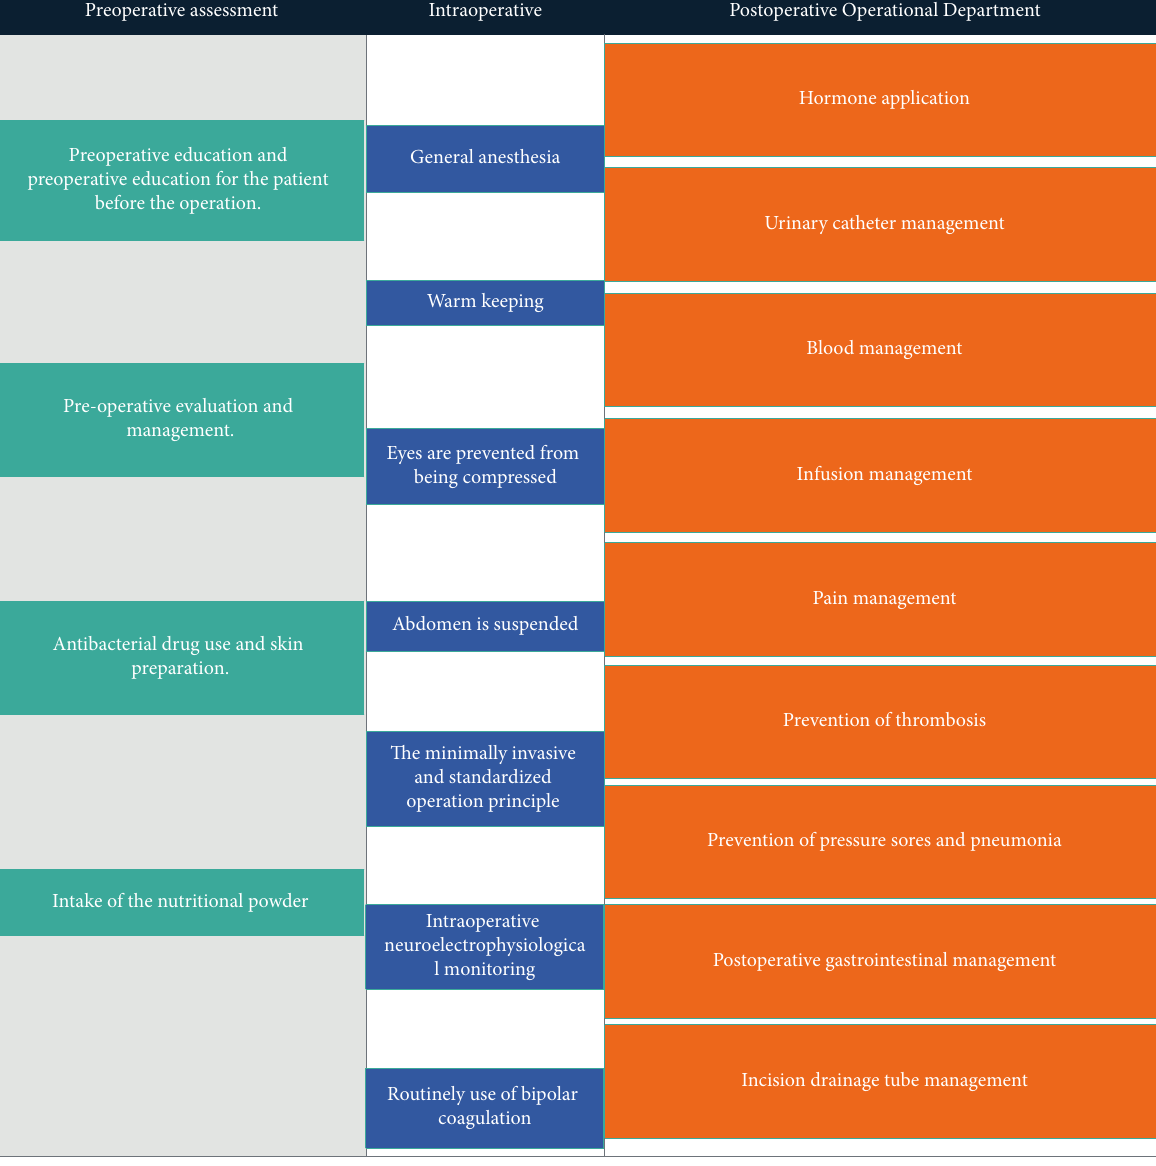
Figure 1: Summary of conducted perioperative topics for ERAS with